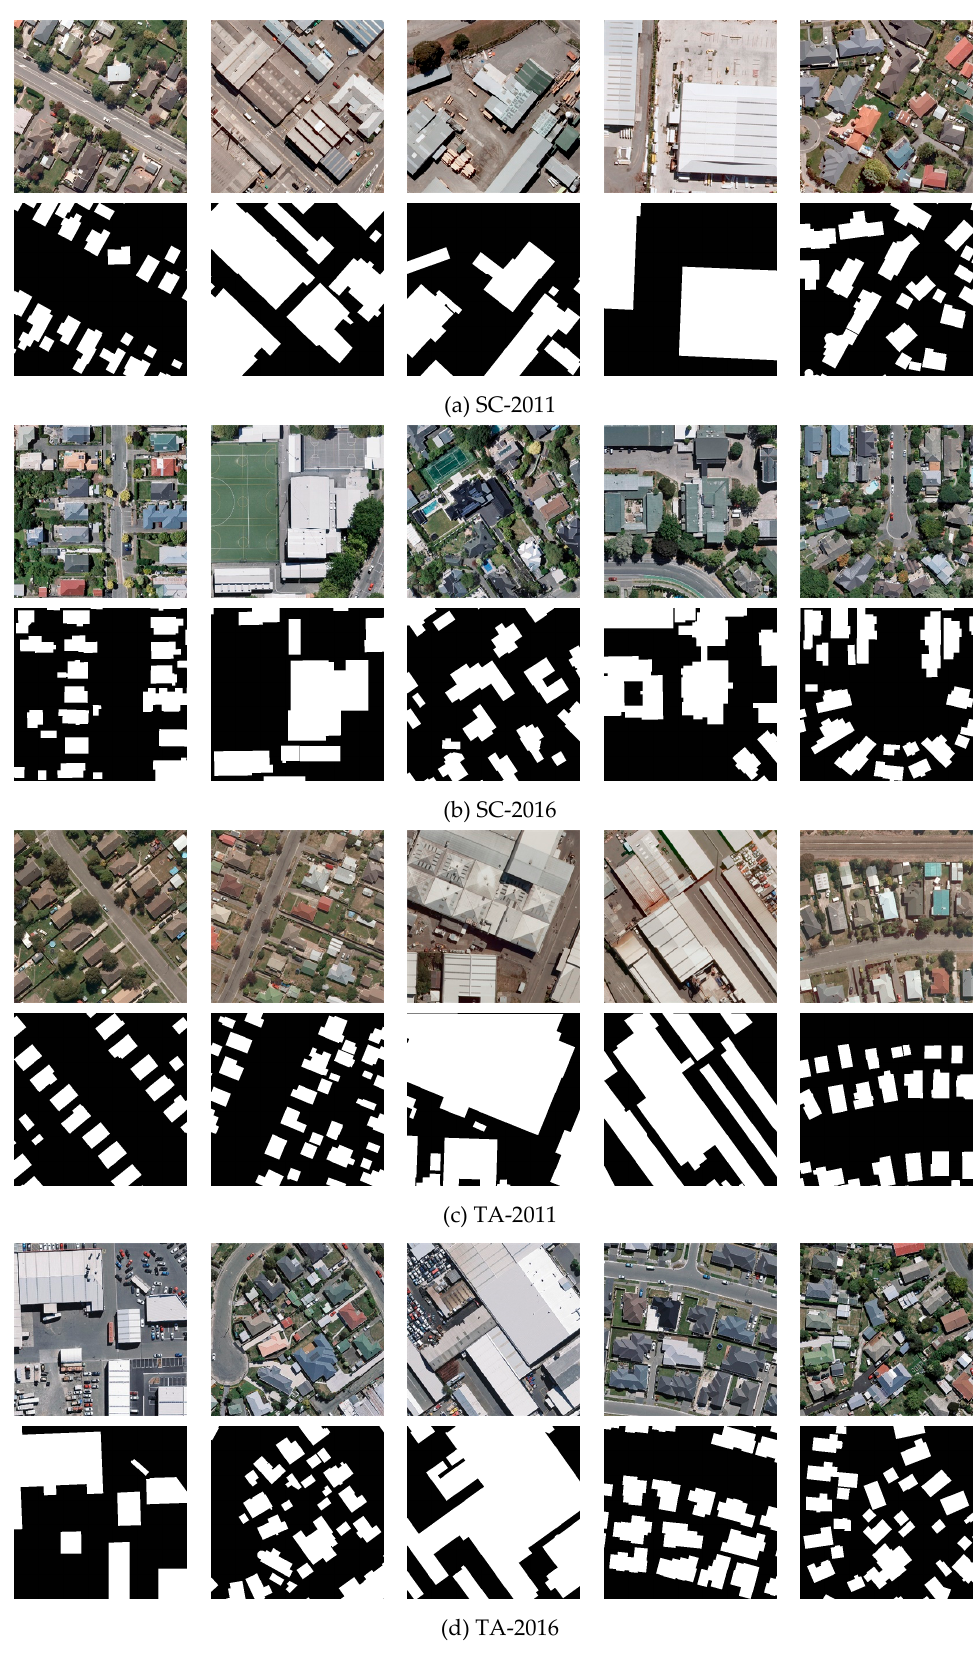
Figure 7. Examples of the SC-2011, SC-2016, TA-2011 and TA-2016 sub-datasets.